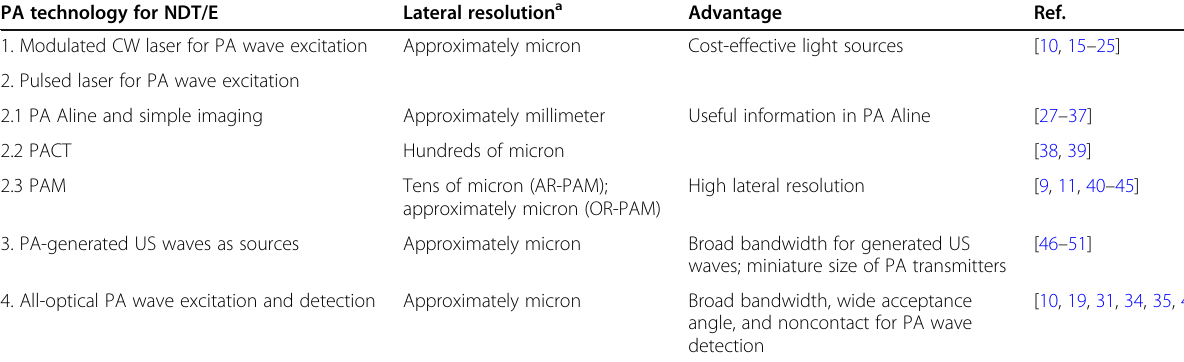
Table 1 Summary of PA technologies used for NDT/E PA technology for NDT/E